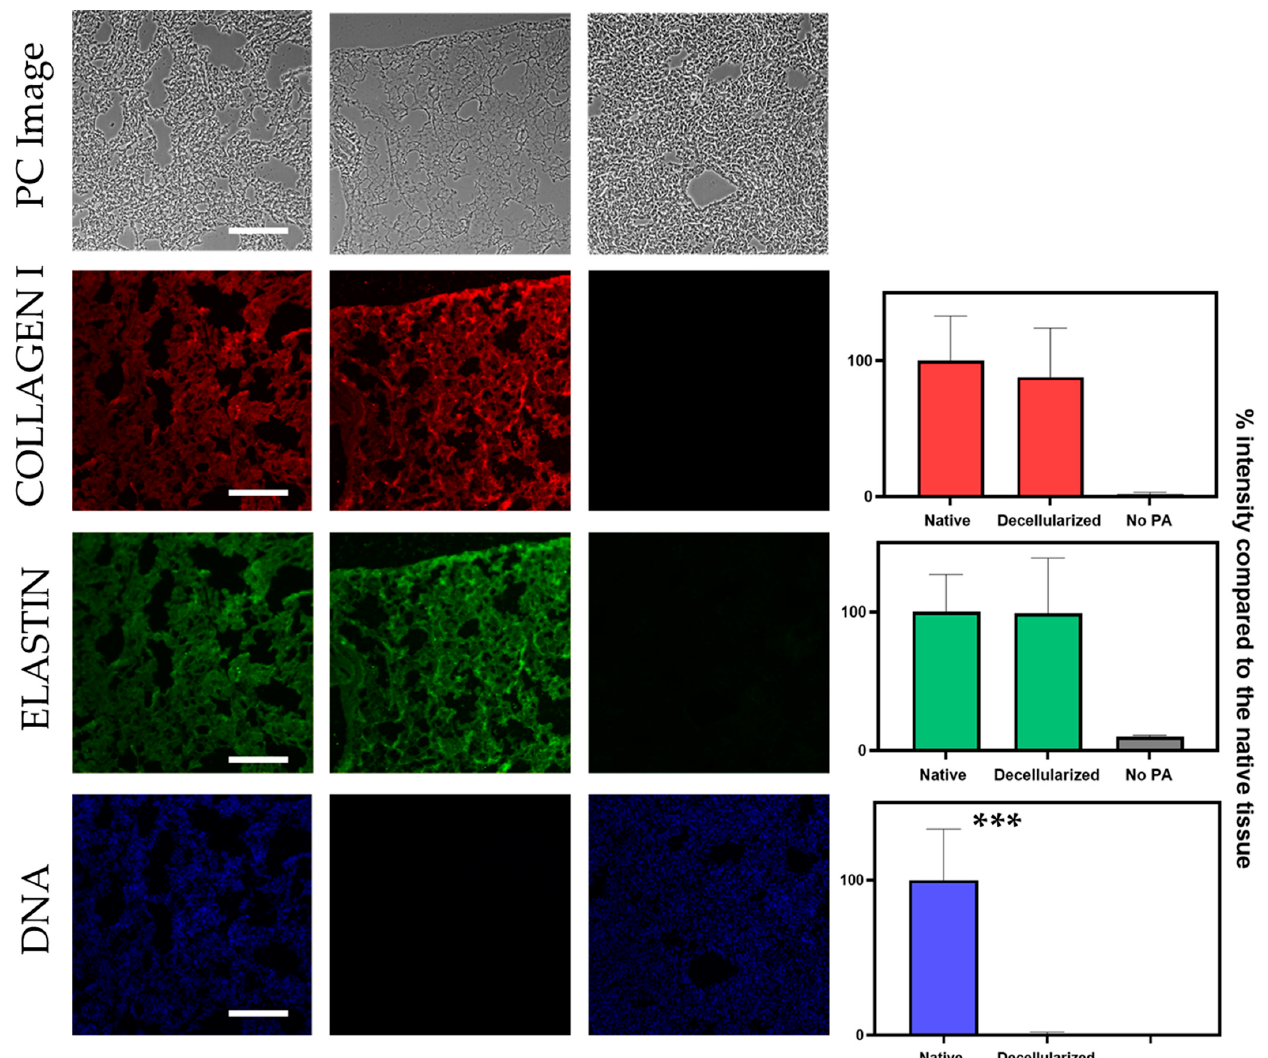
Figure 5. Simultaneous signal quantification of DNA, collagen and elastin signal based on segmentation of the corresponding PC image. The left column corresponds to a native lung section, the middle column corresponds to a decellularized lung section and the right column corresponds to a native section that was not treated with PA. Scale bar corresponds to 200 µm. The contrast of PC images has been increased for the sake of readability. Unpaired t-test for significance between native and decellularized groups with p -value *** p < 0.001. A minimum of 8 sections were used per datapoint.